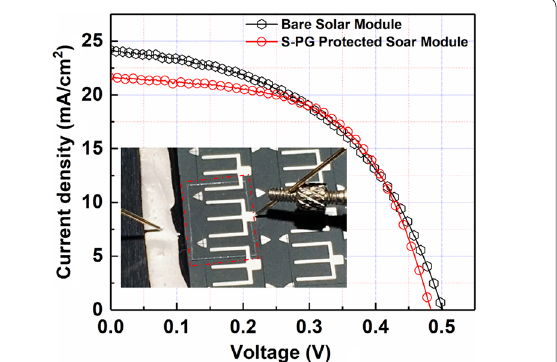
Fig. 3 The static water contact angle (WCA) of the siloxane functionalized GO incorporated PUA (S‑PG) composite film as a function of µ‑pillar distance